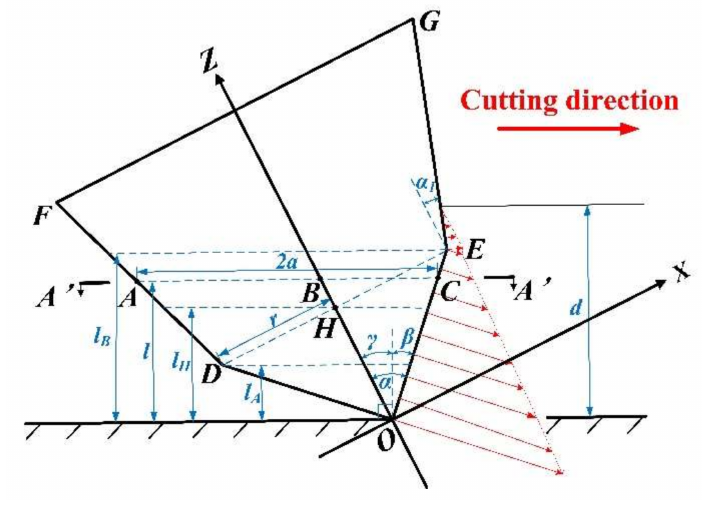
Figure 1. The diagram of the pick tip stress